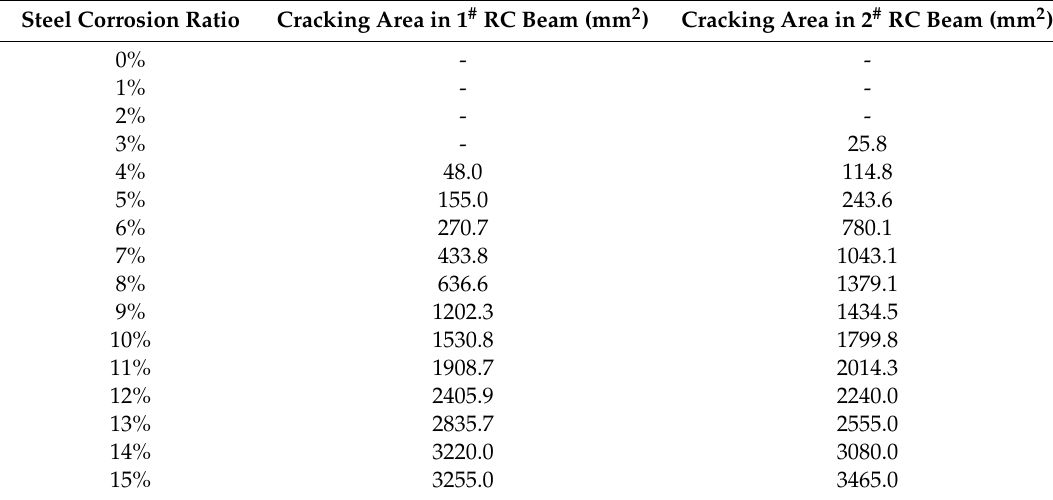
Table 3. Results for cracking area in RC